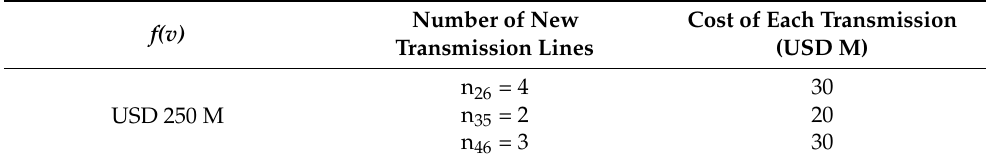
Table 4. Optimal results based on nine reduced